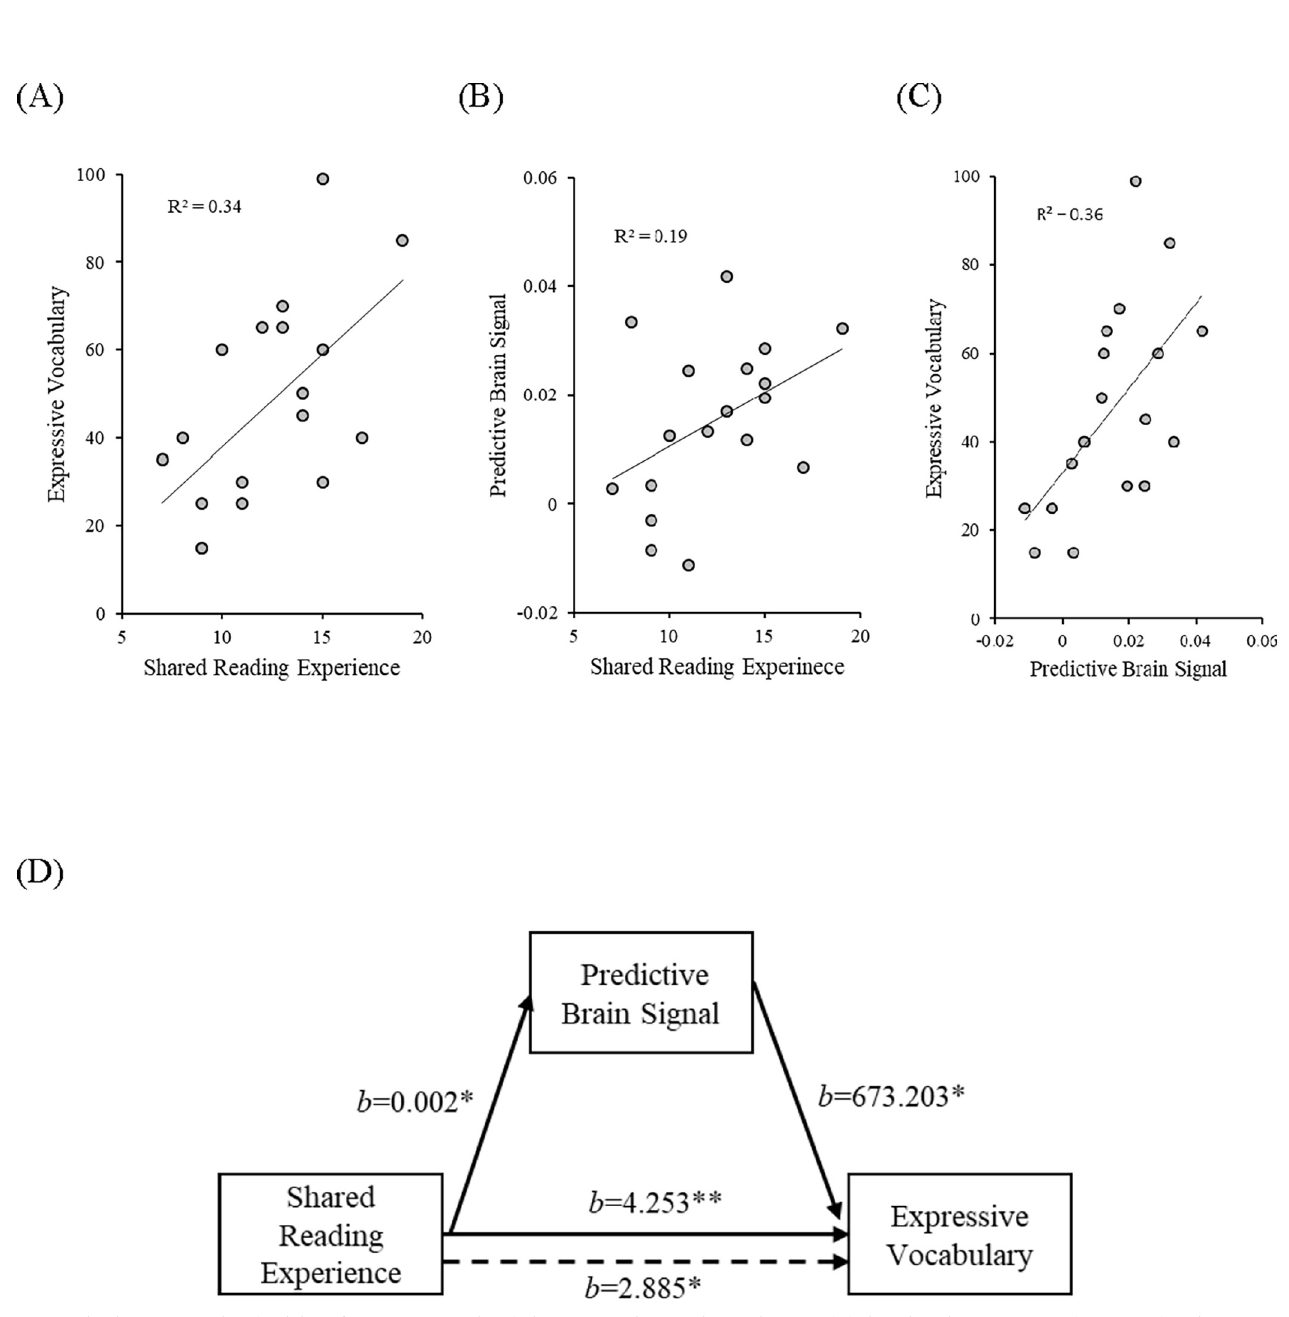
Fig 4. The three scatter plots (with best-fitting regression lines) show zero-order correlations between (A) shared reading experience (raw scores) and expressive vocabulary (PR), (B) shared reading experience (raw scores) and predictive brain signal (oxy-Hb; mM), (C) predictive brain signal (oxy-Hb; mM) and expressive vocabulary (PR). The mediation model (D) shows the effect of shared reading experience on expressive vocabulary, as mediated by predictive brain signal. Along the lower path, the solid and dashed arrows show results when the mediator was not included and was included in the model, respectively. Asterisks indicate significant paths ( �� p < .01, � p <